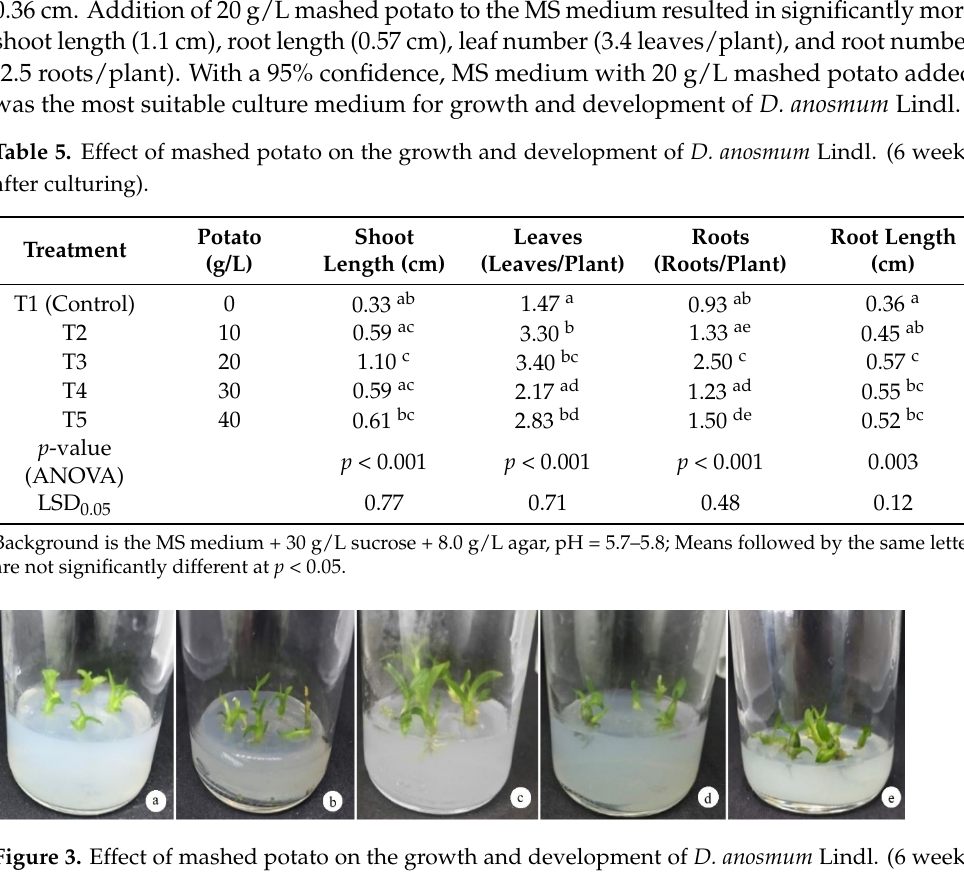
Figure 3. Effect of mashed potato on the growth and development of D. anosmum Lindl. (6 weeks after culturing): ( a ) MS, ( b ) MS + 10 g/L potato, ( c ) MS + 20 g/L potato, ( d ) MS + 30 g/L potato, and ( e ) MS + 40 g/L